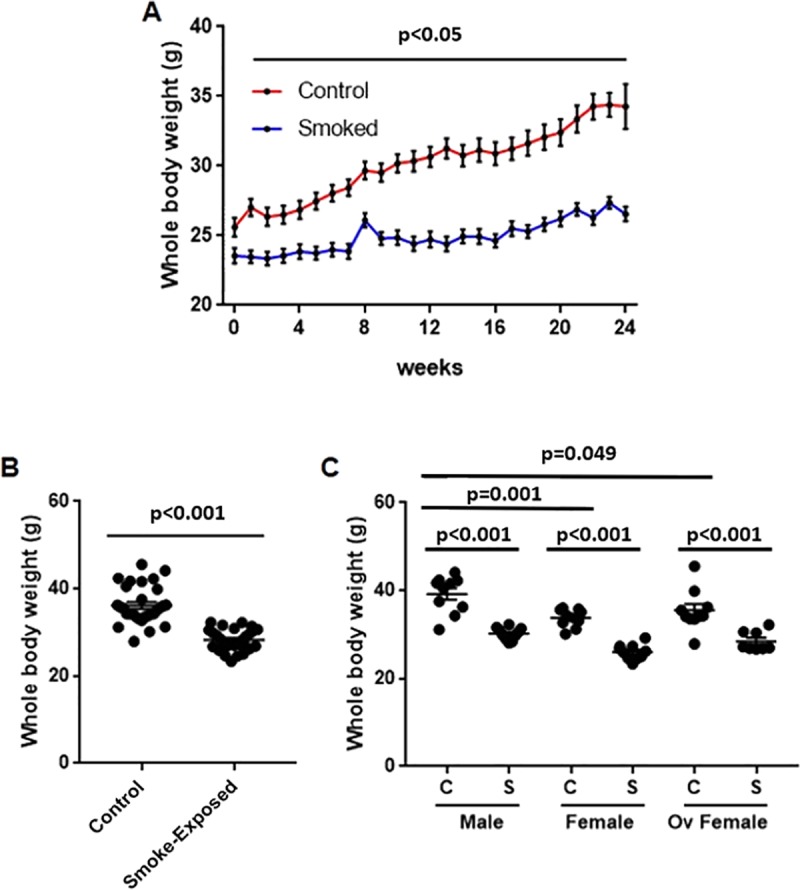
Chronic smoke exposure reduced the ability to gain body weight in mice.A) Whole-body weight over time is shown in mice stratified by smoke exposure (control vs. smoke-exposed). Whole-body weights at week 24 are shown in mice stratified by smoke exposure (B) and by both smoking and sex (C). In panel A, a two-way analysis of variance (ANOVA) with Bonferroni’s multiple comparisons test was applied, whereas in panels B and C a two-tailed unpaired t-test and one-way ANOVA with Bonferroni’s multiple comparisons test was used, respectively. C = control; S = smoke-exposed.